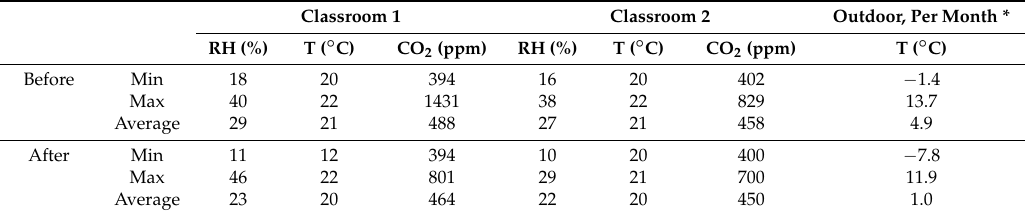
Table 2. Minimum, maximum and average values of RH, T, and CO 2 in Classrooms 1 and 2, during